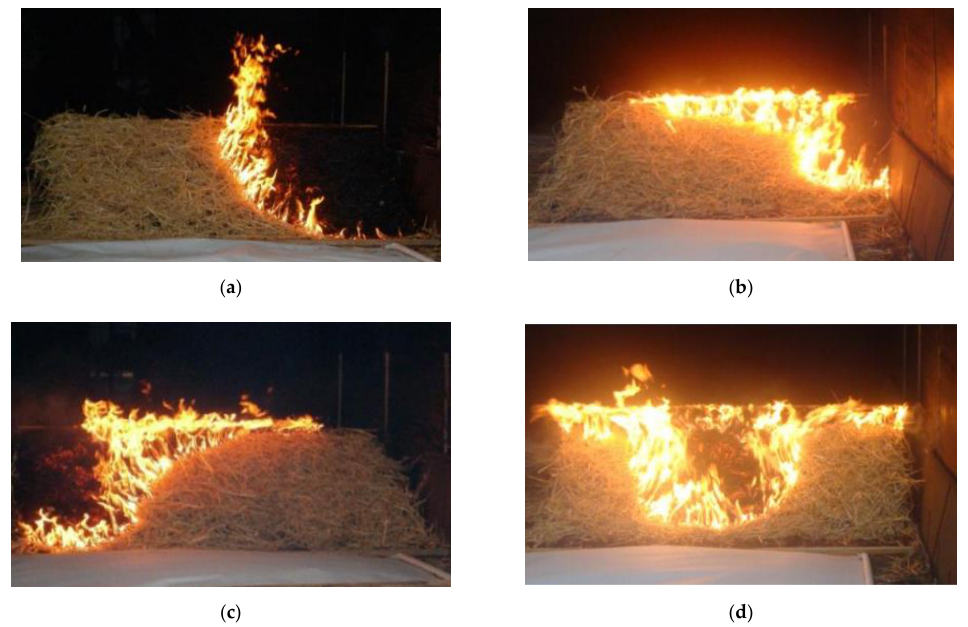
Figure 3. Empirical fires which burn across the lee slope. ( a ) No wind, right-side ignition; ( b ) 4 m s −1 wind, right side ignition; ( c ) 4 m s -l wind, left side ignition; ( d ) 4 m s -l wind, central ignition [30].